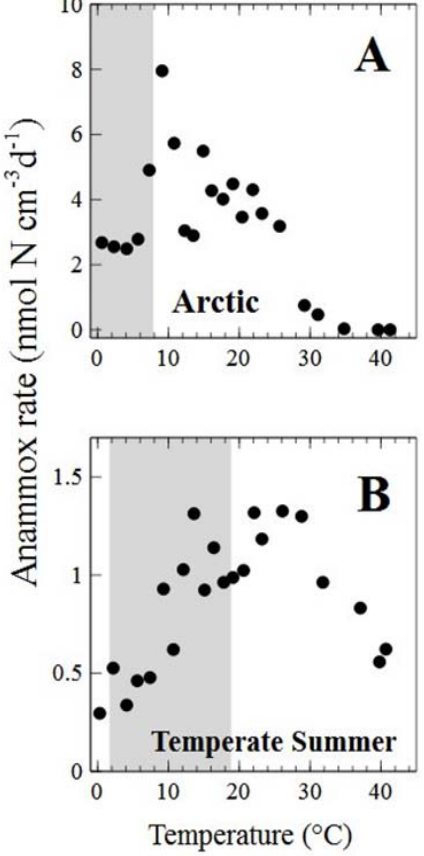
Fig. 4. Potential anammox rates measured in temperature gradient block experiments for (A) Ymerbukta and (B) Sylt (June 2007). Rates were measured with a 15 NH + label. Estimates of standard 4 error were not made because rates were calculated from two time points. Note different y axis scaling.